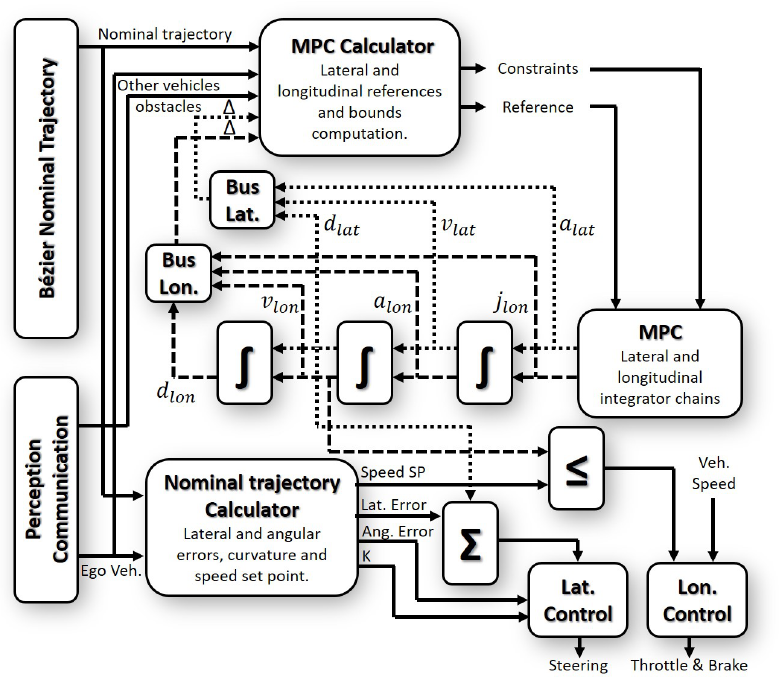
Figure 4. Model Predictive Control (MPC) approach block